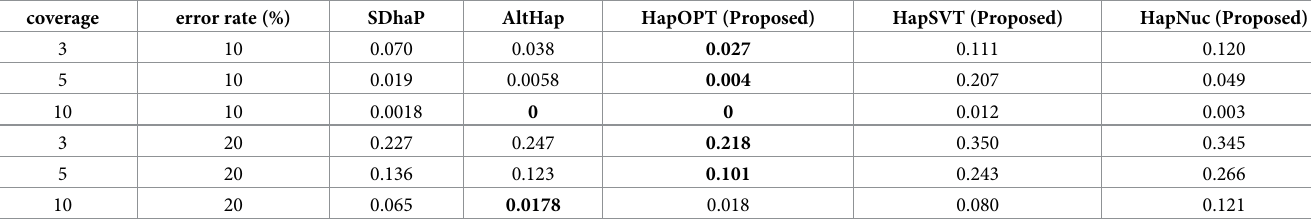
Table 4. SWERs for different algorithms on simulated data [21]. The best values are in boldface. coverage error rate